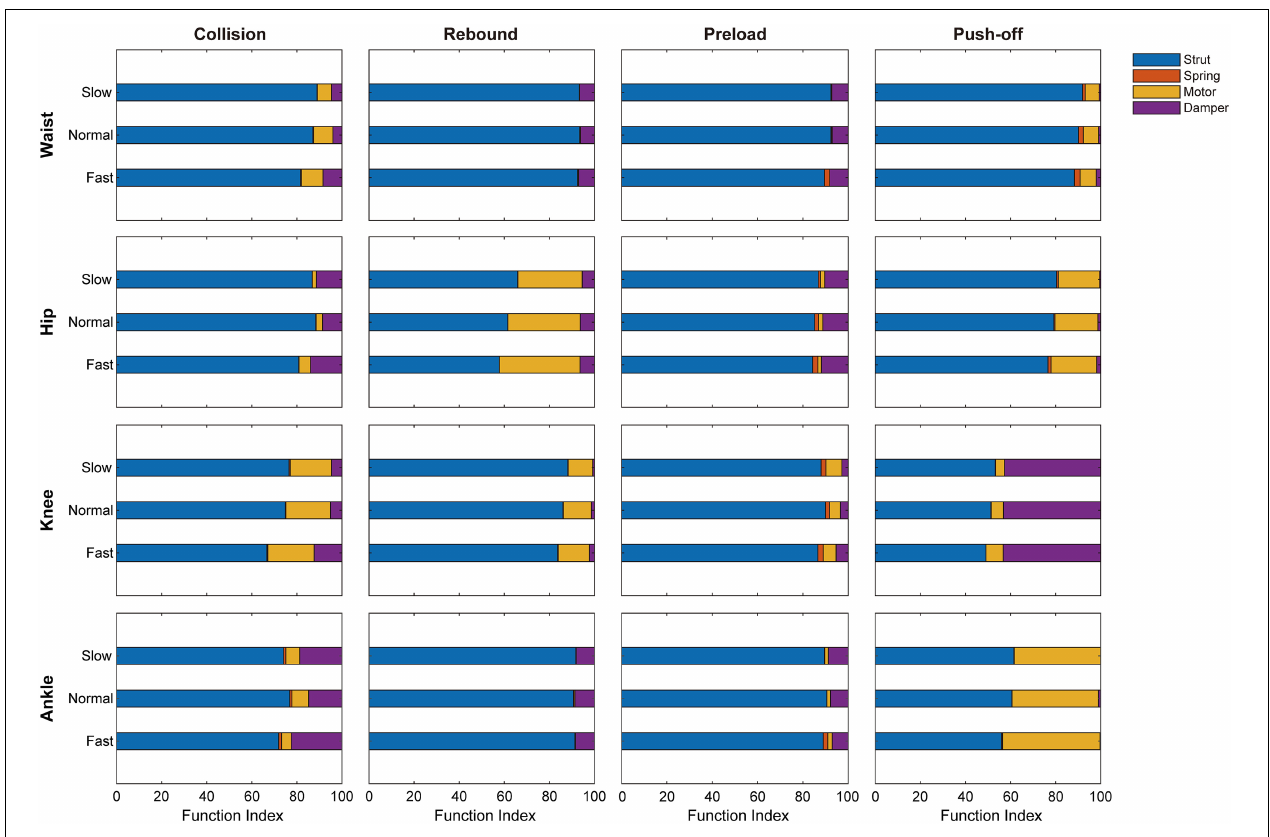
FIGURE 4 | The functional indices of joints during different phases across three walking speeds. N = 6; means were